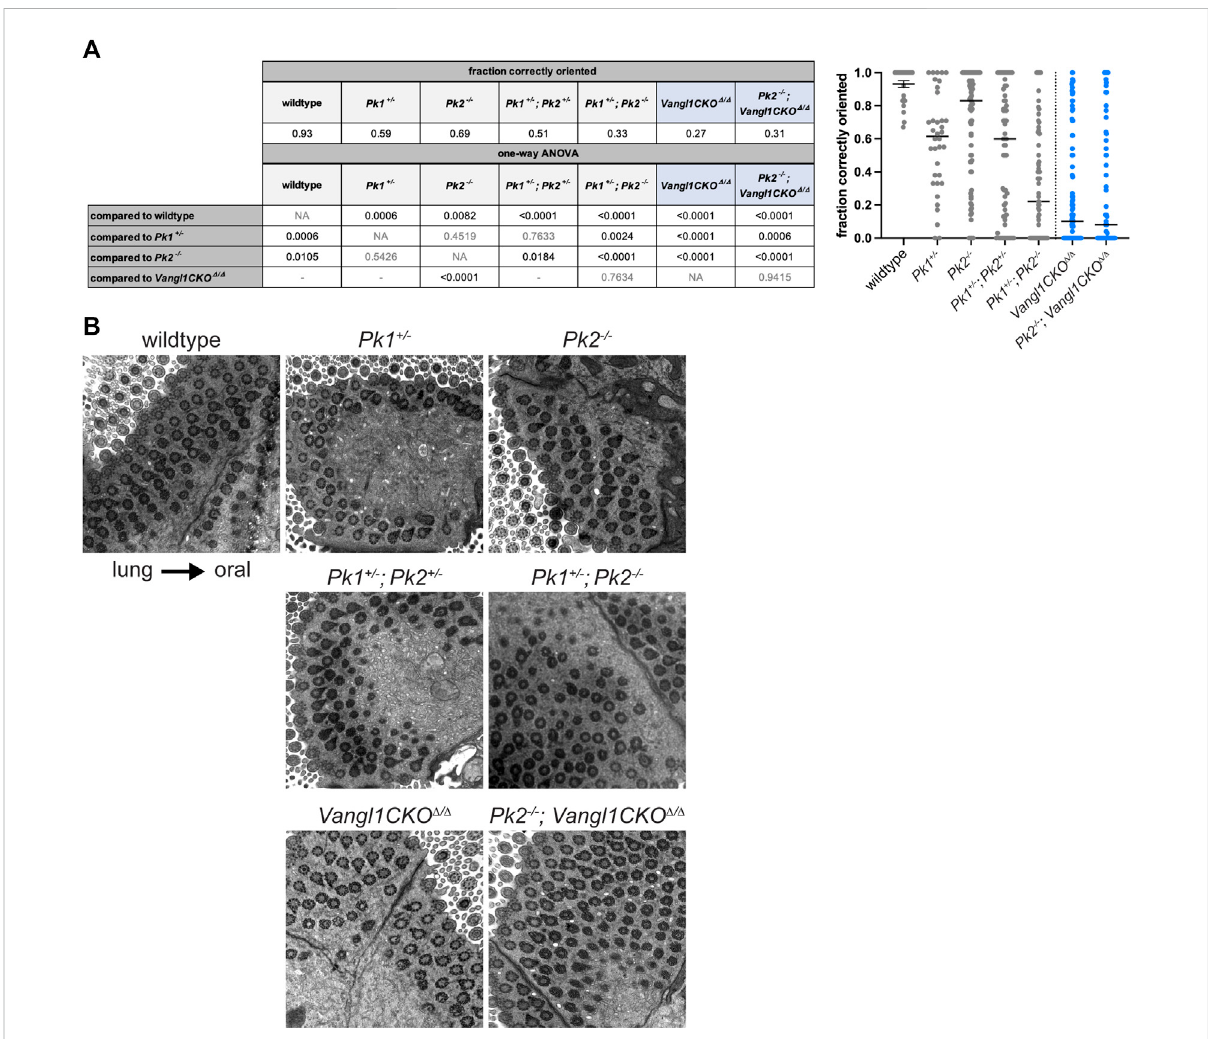
FIGURE 3 Basal body orientation in adult Pk mutant multiciliated cells. (A) . Basal body misorientation metrics in adult Pk mutants with appropriate statistics. Vangl1CKO Δ / Δ and Pk2 − / − data were used from (Vladar et al., 2016) with permission. Fraction of correctly oriented basal feet per cell is plottedinthegraph(right).Resultsfromaone-wayANOVAareshowninthetable(left)asfollows:statisticallysigni fi cant p -valuesareshowninblack, nonsigni fi cant p -values are shown in grey, grey "- ” indicates tests that are not shown. Vangl1CKO Δ / Δ containing genotypes are highlighted in blue. (B) . Representative TEM images showing basal foot orientation with respect to tissue